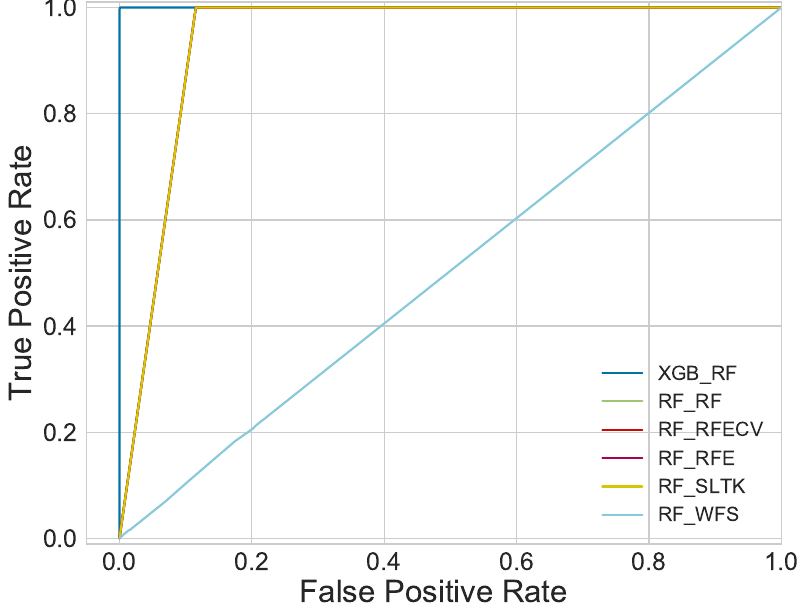
Figure 4. ROC Curve for Gafgyt.udp vs. all classes. Note that ROCs for RF-RF, RF-RFECV, RF-RFE, RF-SelectKBest, and RF-WFS are